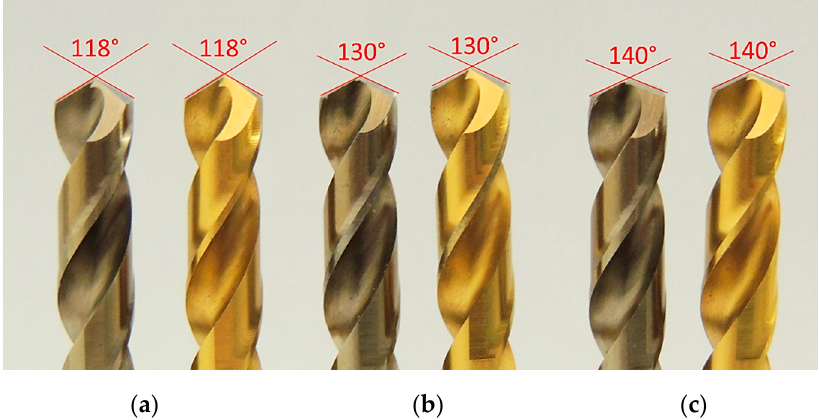
Figure 1. Sharpening of the two types of drill with the point angles of: ( a ) 118°, ( b ) 130° and ( c ) 140° from left to right.